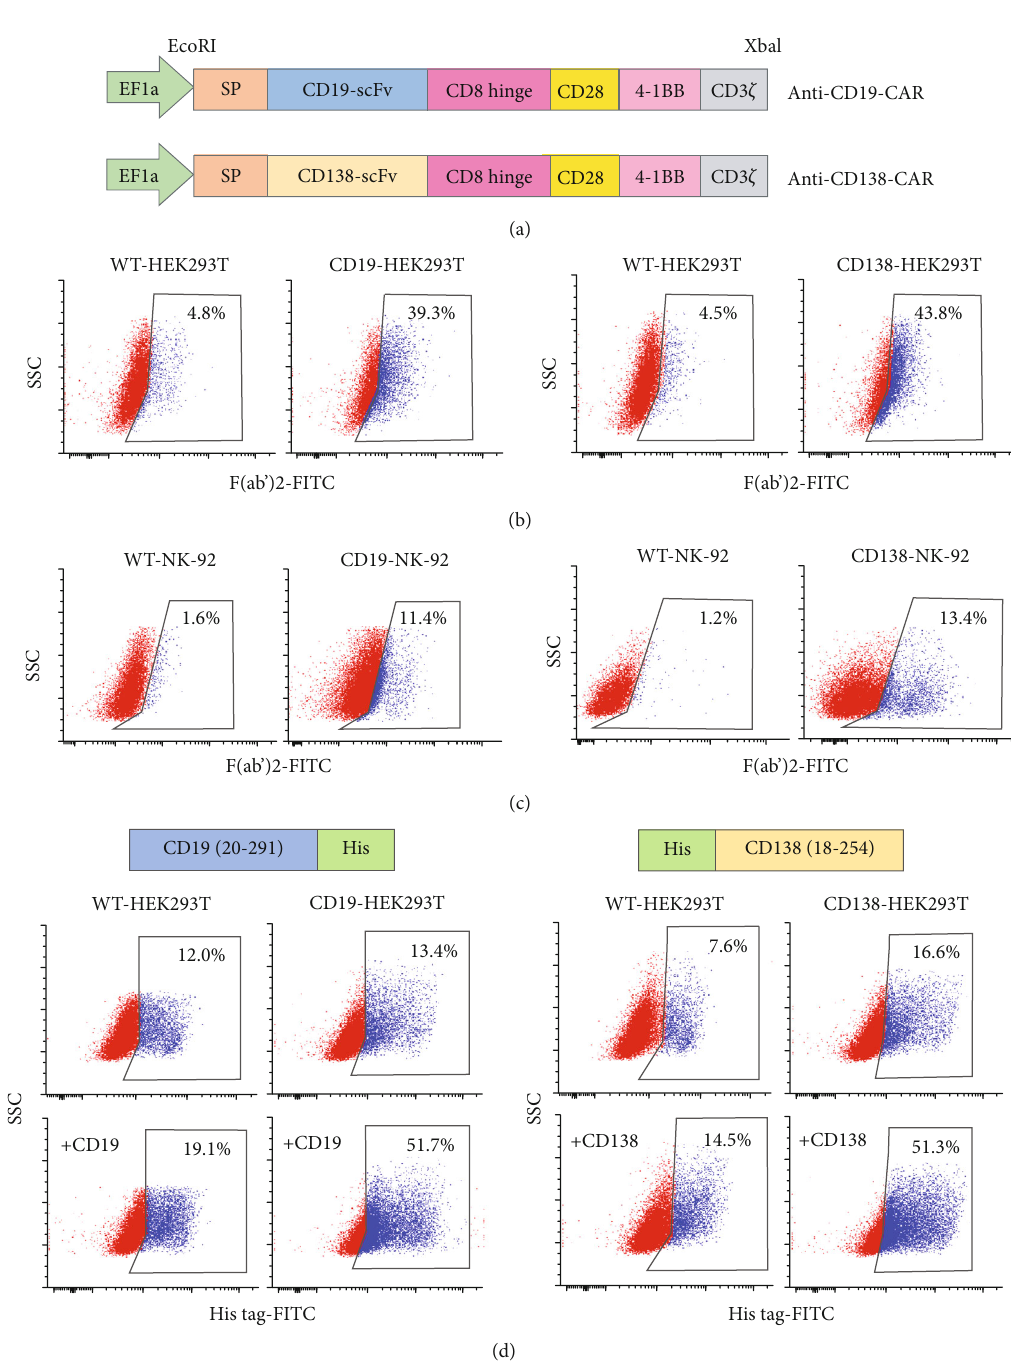
Figure 1: Construction of anti-CD19-CAR and anti-CD138-CAR and detection of CAR expression. (a) Diagram of the lentiviral vectors encoding third-generation CARs to target CD19 ( upper ) or CD138 ( lower ) antigen, designated as anti-CD19-CAR or anti-CD138-CAR, under the control of EF1a promoter and the restriction enzyme cutting sites EcoRI and Xbal. (b) CAR expression on the surface of CD19-HEK293T ( left ) or CD138-HEK293T ( right ) cells after transfection of anti-CD19-CAR or anti-CD138-CAR together with pCMV.dR8.2 dvpr and pCMV-VSV-G plasmids, as evaluated by fl ow cytometry using anti-F(ab ′ )2 antibody. (c) CAR expression in CD19-NK-92 ( left ) or CD138-NK-92 ( right ) cells after fi rst round of lentiviral transduction, as similarly evaluated using anti-F(ab ′ )2 antibody. (d) CAR expression in CD19-HEK293T ( left ) or CD138-HEK293T ( right ) cells, as evaluated by fl ow cytometry based on its antigen-binding activity to His tag-rhCD19 or His